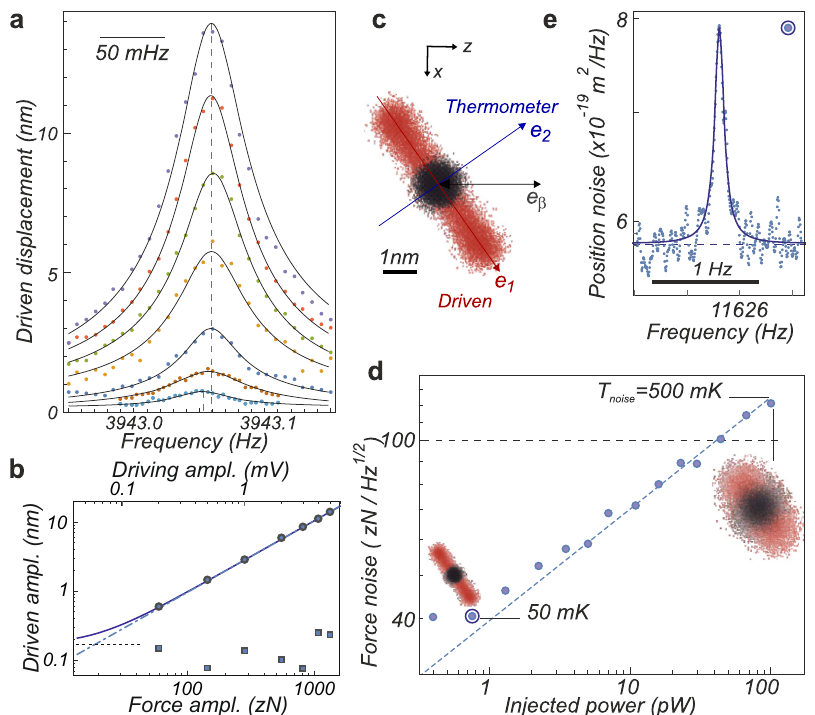
Fig. 5 Force sensing. a Response measurements obtained for increasing piezo actuation voltages (50mHz resolution bandwidth). The fi tted resonant amplitudes and background values (not rms) are reported in ( b ) as circles and squares respectively. The linearity of the system is well veri fi ed, with driving force ffiffiffiffiffiffiffiffiffiffiffiffiffiffiffiffiffiffiffiffiffiffiffiffiffiffiffi q δ F Þ 2 þ N amplitudes spanning from 59zN to 2.9aN ( Γ m /2 π = 40mHz here). The solid line represents ð χ with χ 2 = 1.0×10 10 mN − 1 where the 2 displacement noise power N integrated over the resolution bandwidth is indicated as a dashed line. c Sketch of the measurement con fi guration realized on a 11kHz nanowire: mode 1 is resonantly driven to an amplitude of 1.5nm (1.8aN drive amplitude), while the noise temperature is simultaneously measured on mode 2. The red and black trajectories illustrate the driven and non driven situations. d Dependence of the force noise of eigenmode 2 for increasing optical guide line. The noise temperatures are indicated for 2 points in that plot, see readout powers, while resonantly driving mode 1. The dashed line is a P 1 = 2 opt Supplementary Note 9. e Corresponding thermal noise spectrum obtained using 750fW, featuring a 50mK noise temperature corresponding to a 40zNHz − 1/2 force